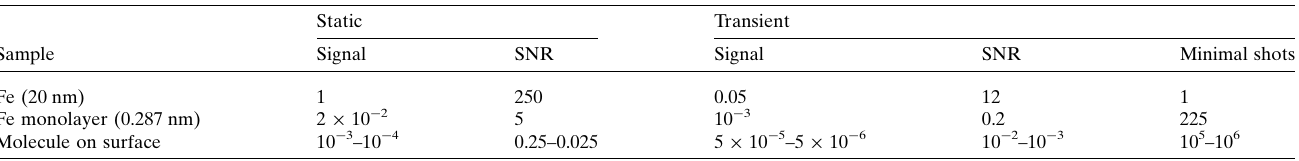
Table 2 Single-shot static and transient XAS signal as well as SNR for different cases. To achieve an SNR greater than 3 for the transient XAS signal, the minimal number of shots is given in the last